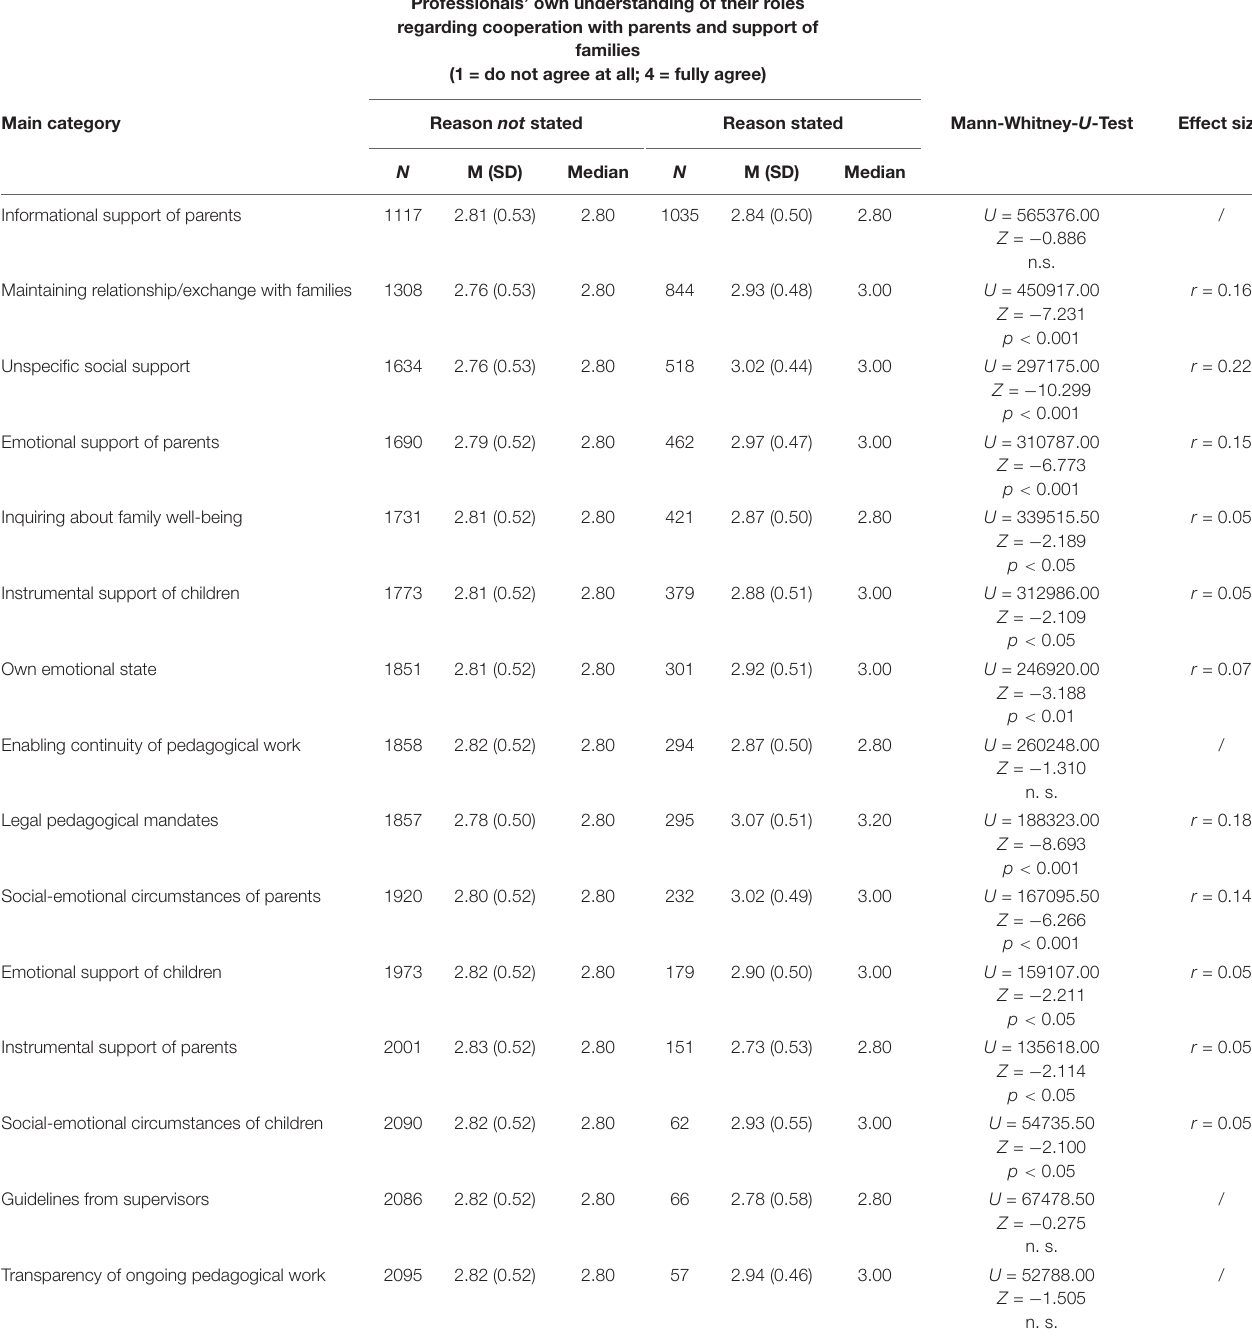
TABLE 4 | Differences in professionals role understanding within reasons for being in contact with parents ( n = 2,152). Professionals’ own understanding of their roles regarding cooperation with parents and support of families (1 = do not agree at all; 4 = fully